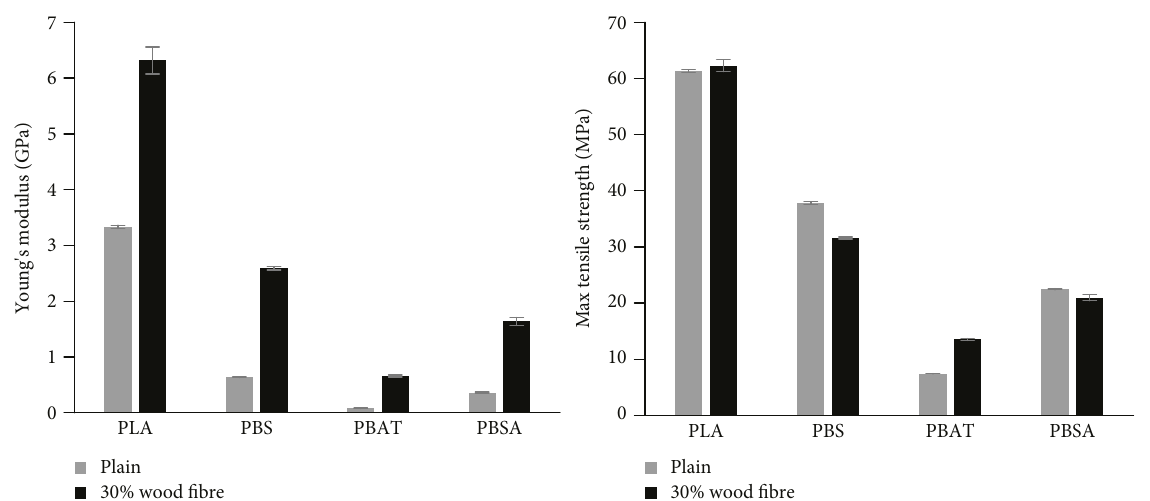
Figure 1: Tensile modulus and maximum tensile strength of injection moulded test samples with four biopolymers, plain or fi lled with 30wt % MDF fi bre (error bars = ± 95% con fi dence interval) ( n = 10